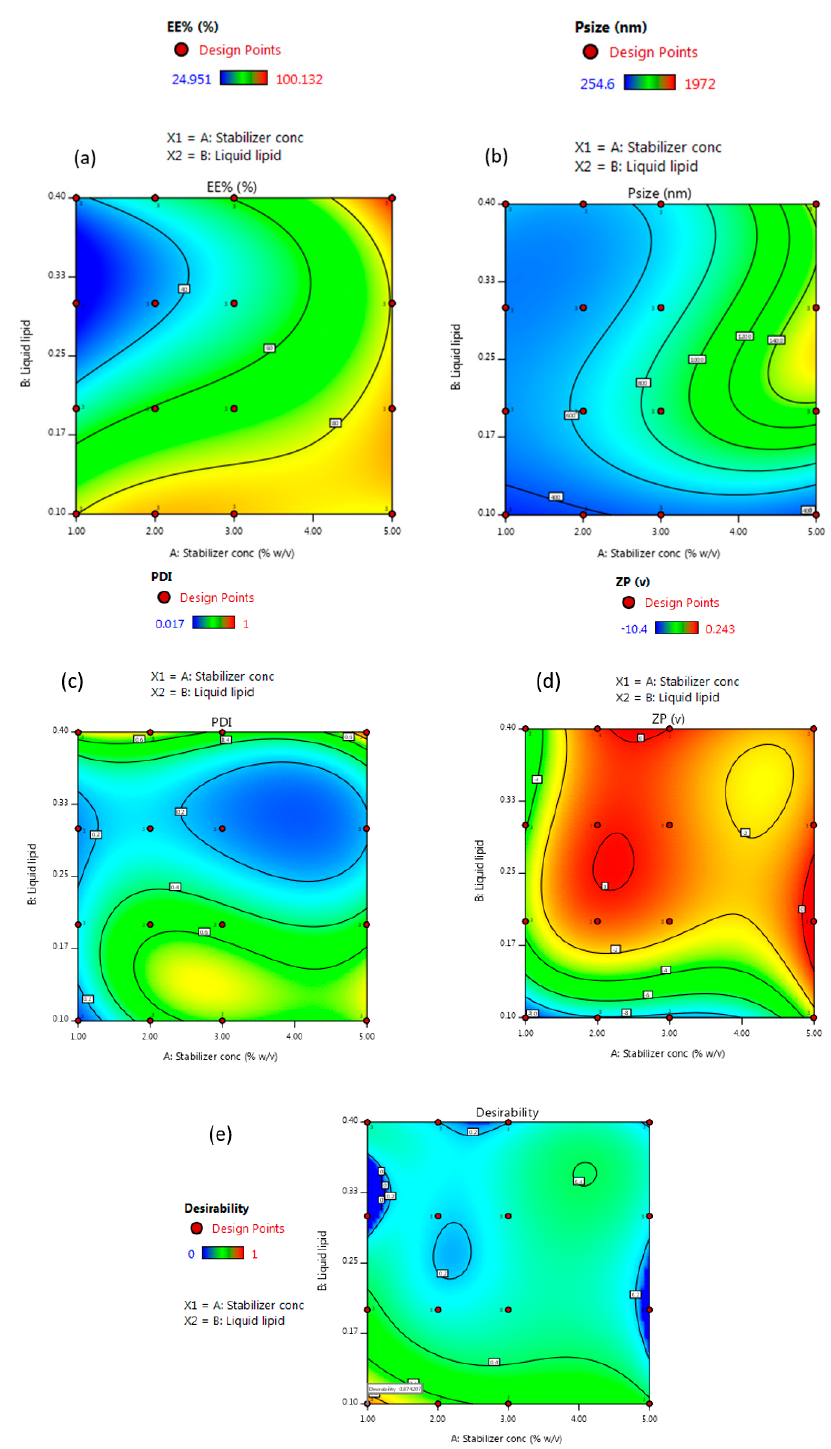
Figure 3. Two-dimensional contour plots showing the effect of stabilizer concentration (A) and liquid lipid type (B) on ( a ) EE%, ( b ) particle size, ( c ) PDI, ( d ) zeta potential, and ( e ) desirability of the prepared NLC formulations.